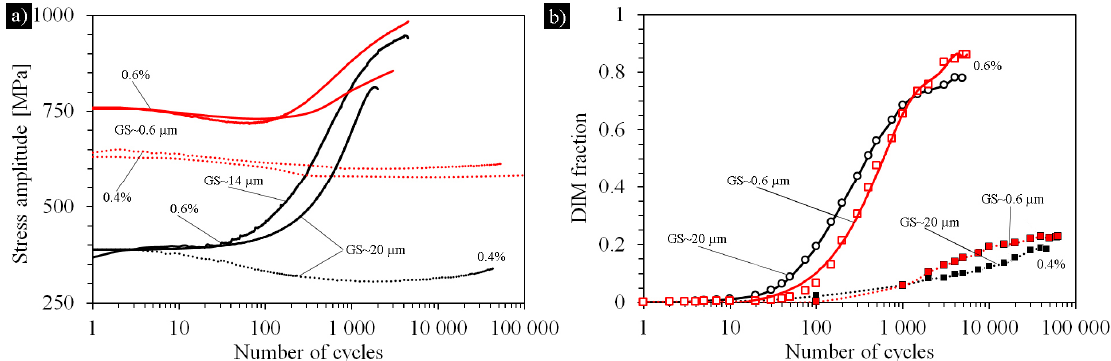
Figure 15. Cyclic medium-life stress amplitude ( a ) and DIM fraction ( b ) vs number of cycles curves of coarse-grained and reversed fine-grained 301LN at 0.4% and 0.6% strain amplitudes. Data from References [87,99,102].